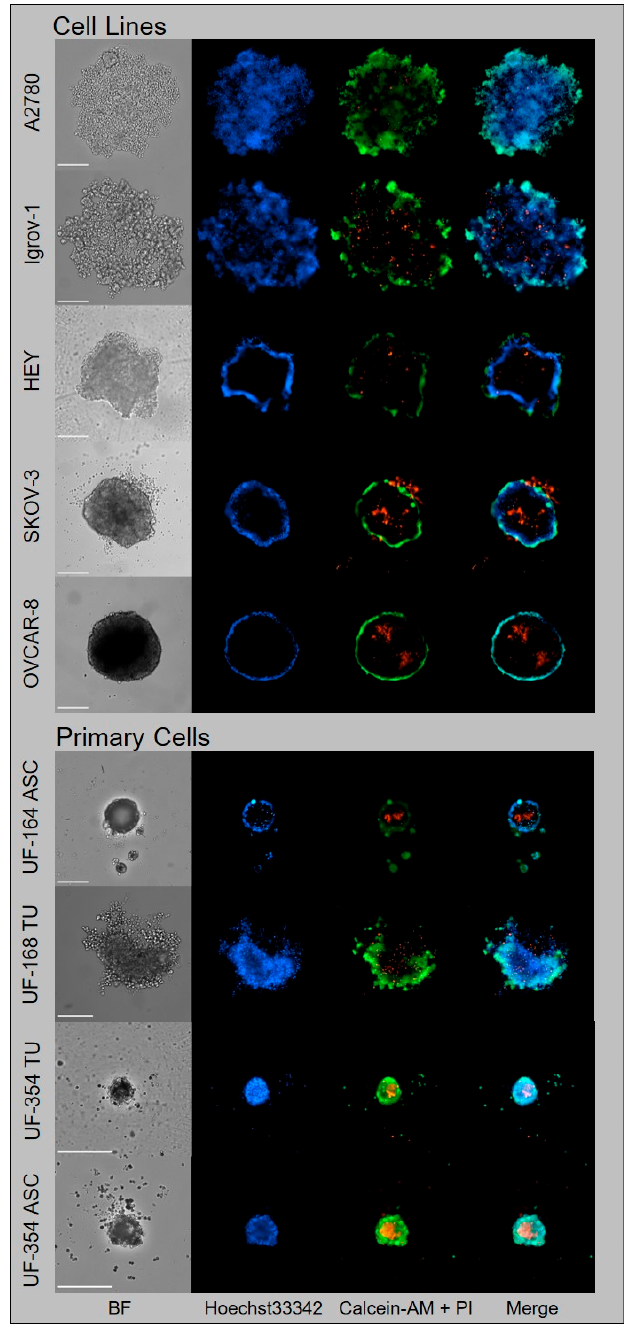
Figure 2. Generation and classification of tumor spheroids using OvCa cell lines and primary OvCa cells. OvCa cell lines and primary OvCa cells from tumor tissue (UF-168 TU and UF-354 TU) or ascites (UF-164 ASC and UF-354 ASC) were seeded in ULA plates and grown for six days for spheroid formation. Triple staining with calcein-AM: living cells, green; propidium iodide (PI): dead cells, red; and Hoechst33342: nuclei, blue revealed different growth types: A2780 and Igrov-1 cells formed loose aggregates indicated by strong central penetration of Hoechst33342 and calcein-AM. HEY cells formed dense aggregates, indicated by the minor central penetration of Hoechst33342 and calcein- AM. SKOV-3 and OVCAR-8 cells formed globe-like dense spheroids with peripheral Hoechst33342 and Calcein-AM staining and a PI-positive core. Spheroids of primary OvCa cells were more compact and showed zonal organization similar to dense spheroids with prominent core formation. Imaging was performed using NYONE ® Scientific (SYNENTEC). Scale = 250 µ m; magnification 10 ×